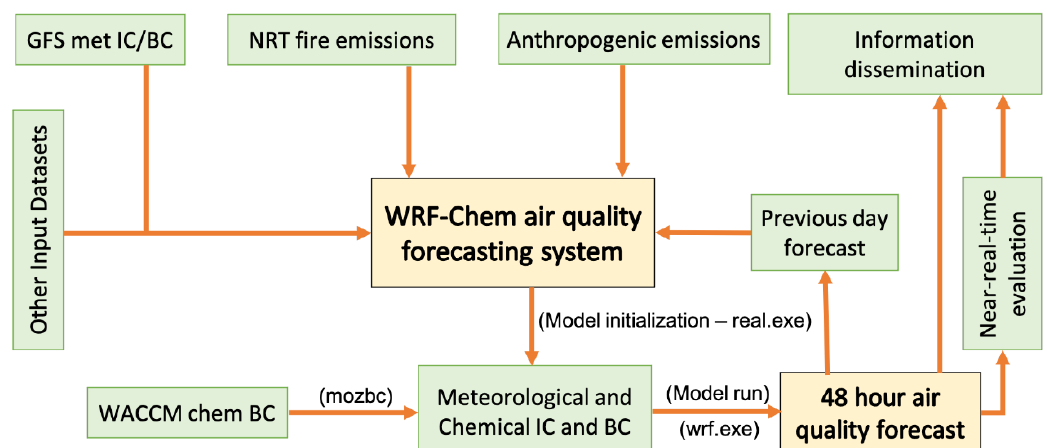
Figure 1. Architecture of the National Center for Atmospheric Research (NCAR) regional air quality forecasting system for the contiguous United States (CONUS). GFS: Global Forecast System; NRT: Near-Real-Time; WACCM: Whole Atmosphere Community Climate Model; IC: Initial conditions; BC: Boundary Conditions.